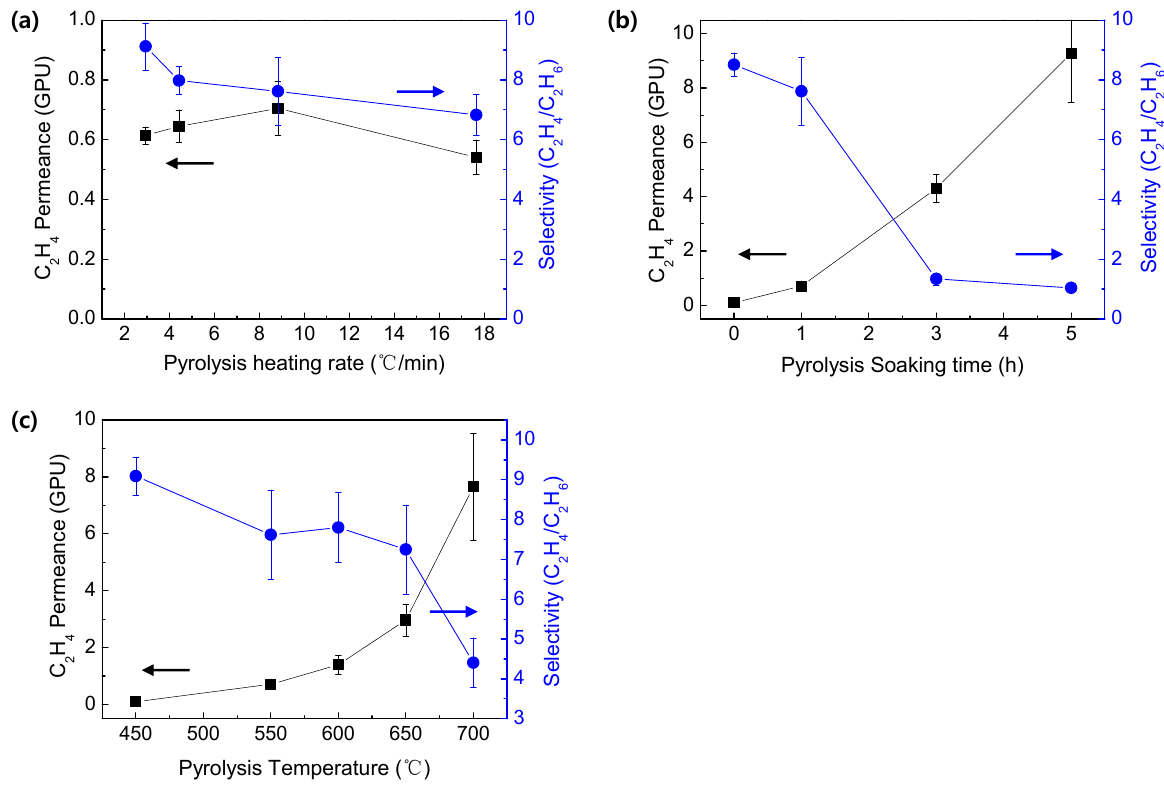
Figure 8. Ethylene/ethane mixed gas separation performance of CMS membranes prepared under various ( a ) pyrolysis heating rates (soaking time: 1 h, pyrolysis temperature: 550 °C), ( b ) pyrolysis soaking time (heating rate: 8.33 °C/min, pyrolysis temperature: 550 °C), and ( c ) pyrolysis temperature (heating rate: 8.33 °C/min, soaking time: 1 h) .